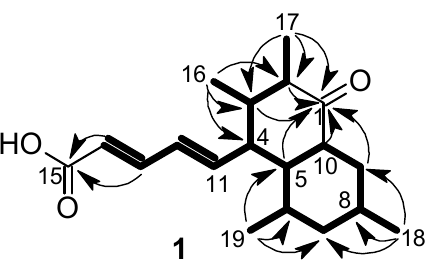
Figure 2. Selected correlation spectroscopy (COSY)/total correlated spectroscopy (TOCSY) (bold lines) and heteronuclear multiple bond (HMBC) (arrows) correlations indicative for the planar structure of elsinopirin A ( 1 ).